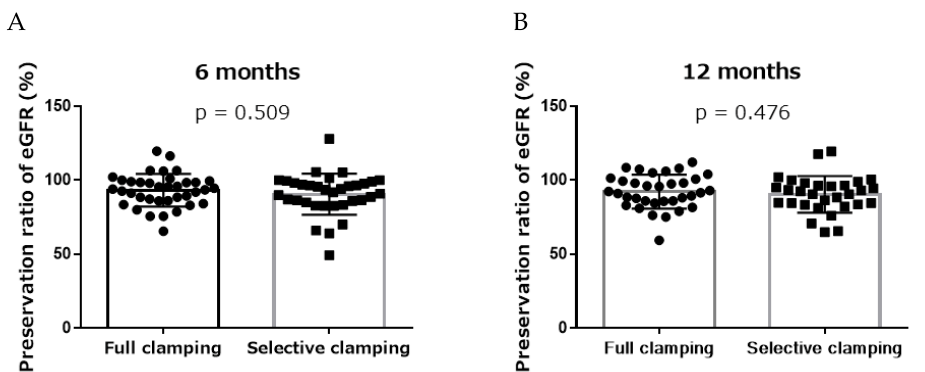
Figure 2. Patients’ functional outcomes. ( A ) 6 months; ( B ) 12 months. Full clamping vs. selective clamping, mean with standard deviation.